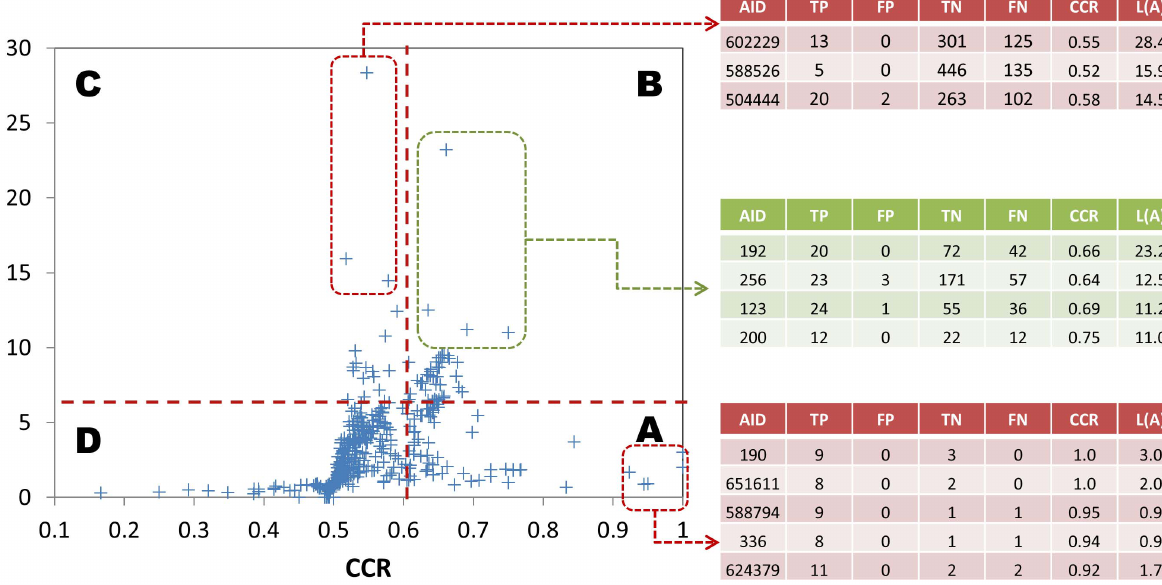
PLOS ONE | www.plosone.org